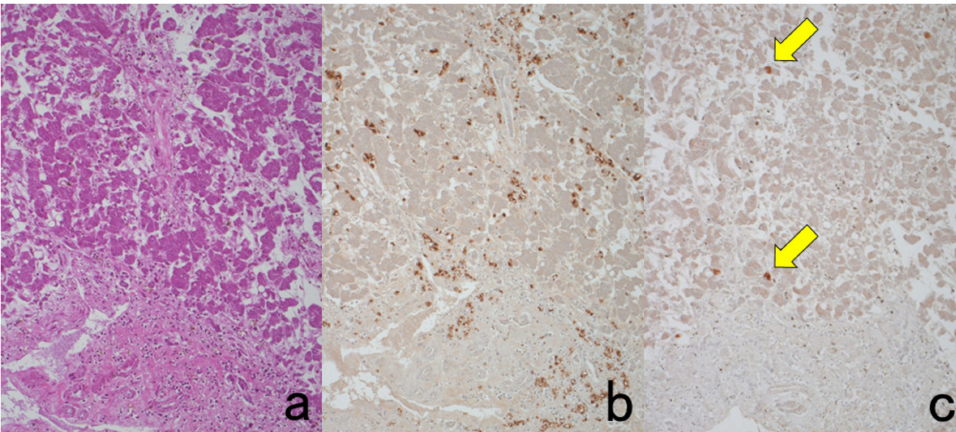
Figure 50. Cross-reactive immunostaining of Mycobacterium leprae in the liver with a rabbit anti-HBs antiserum, immunized with complete adjuvant containing the extract of M. tuberculosis . ( a ): H&E, ( b ): anti-HBs rabbit antiserum, ( c ): anti-HBs monoclonal antibody. Leproma is seen mainly in the portal area. The antiserum visualizes M. leprae in the cytoplasm of macrophages richly distributed both in the portal triad (leproma cells) and in the sinusoid (Kupffer cells). The monoclonal antibody detects HBs antigen-positive hepatocytes (arrows) without background